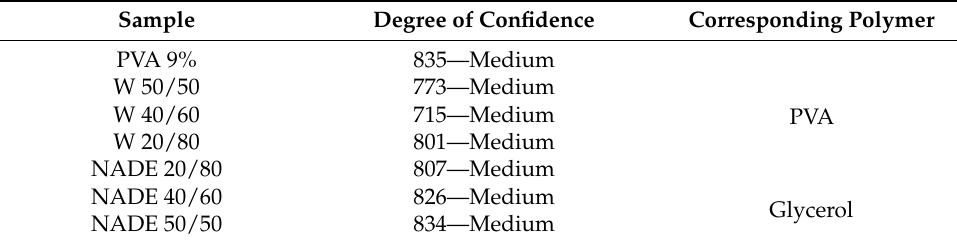
Table 3. Matches found by LabSolutionsIR software for all nanofibers produced. After cross ‐ checking the spectrum data obtained for each sample with the LabSolutionsIR library (Table 3), PVA was found to be the most common match, while Sample